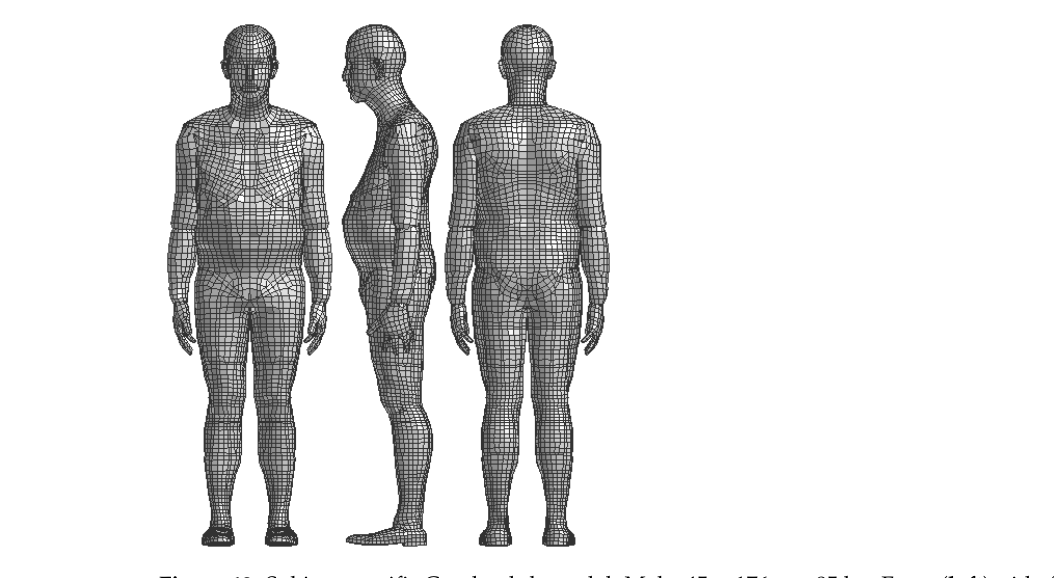
Figure 12. Subject-specific Czech adult model. Male, 45 y, 176 cm, 85 kg. Front ( left ), side ( middle ), and back ( right )